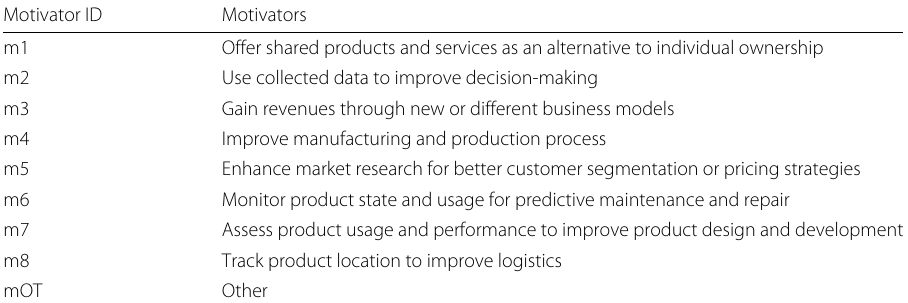
survey participants for